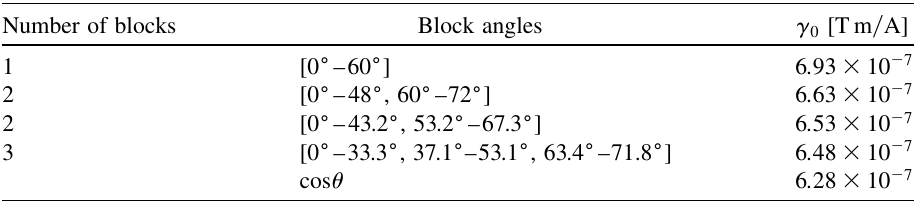
defined in Eq. (17) for different sector coil layouts. 0